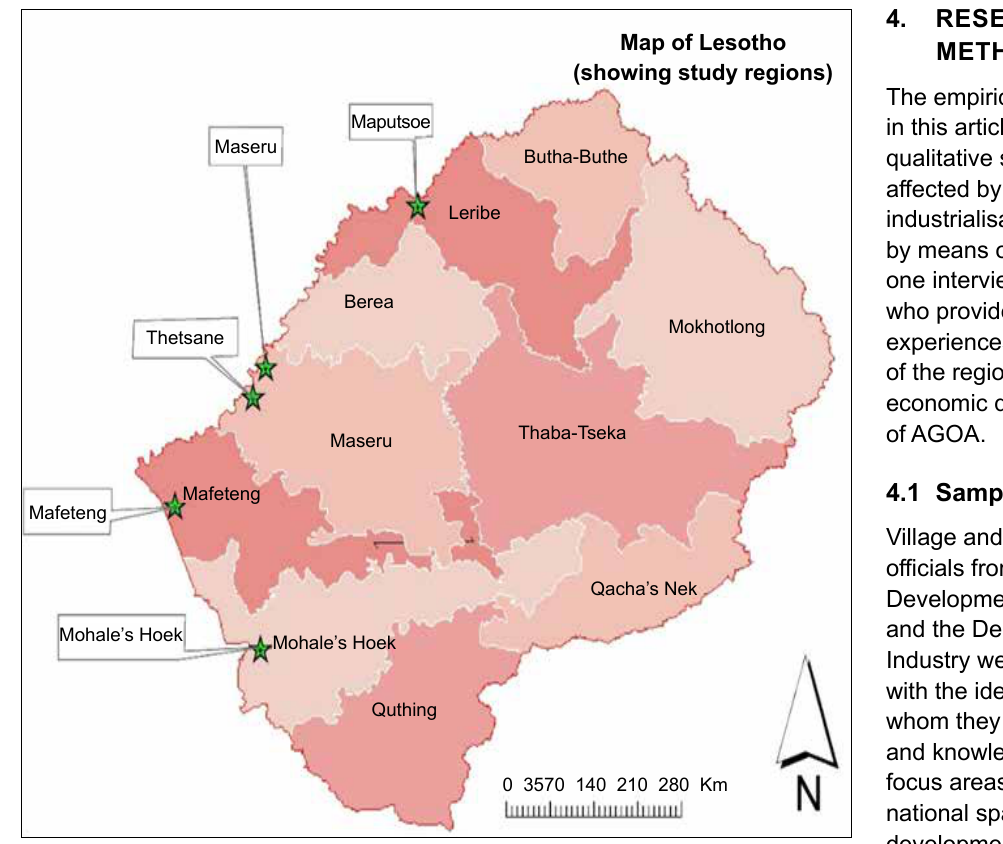
Figure 1: Location of the five industrial estates in